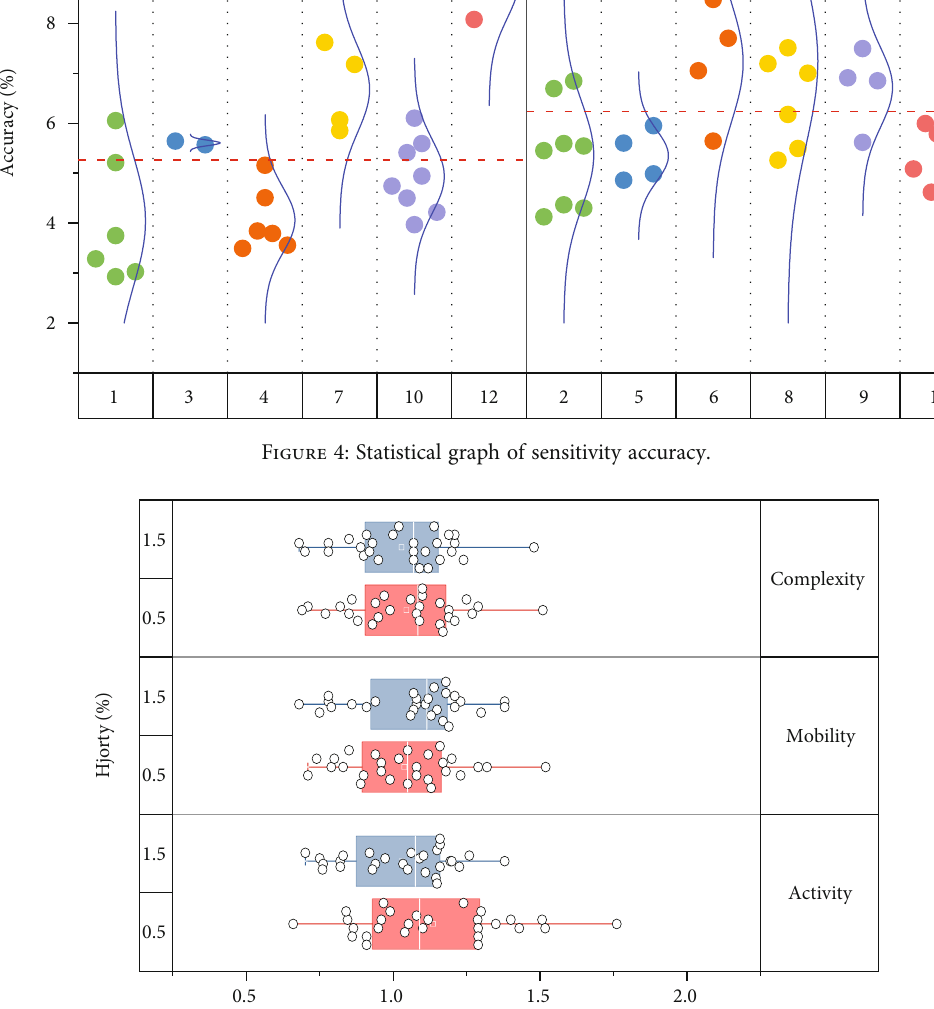
Figure 5: Mean values of Hjorth calculated in various